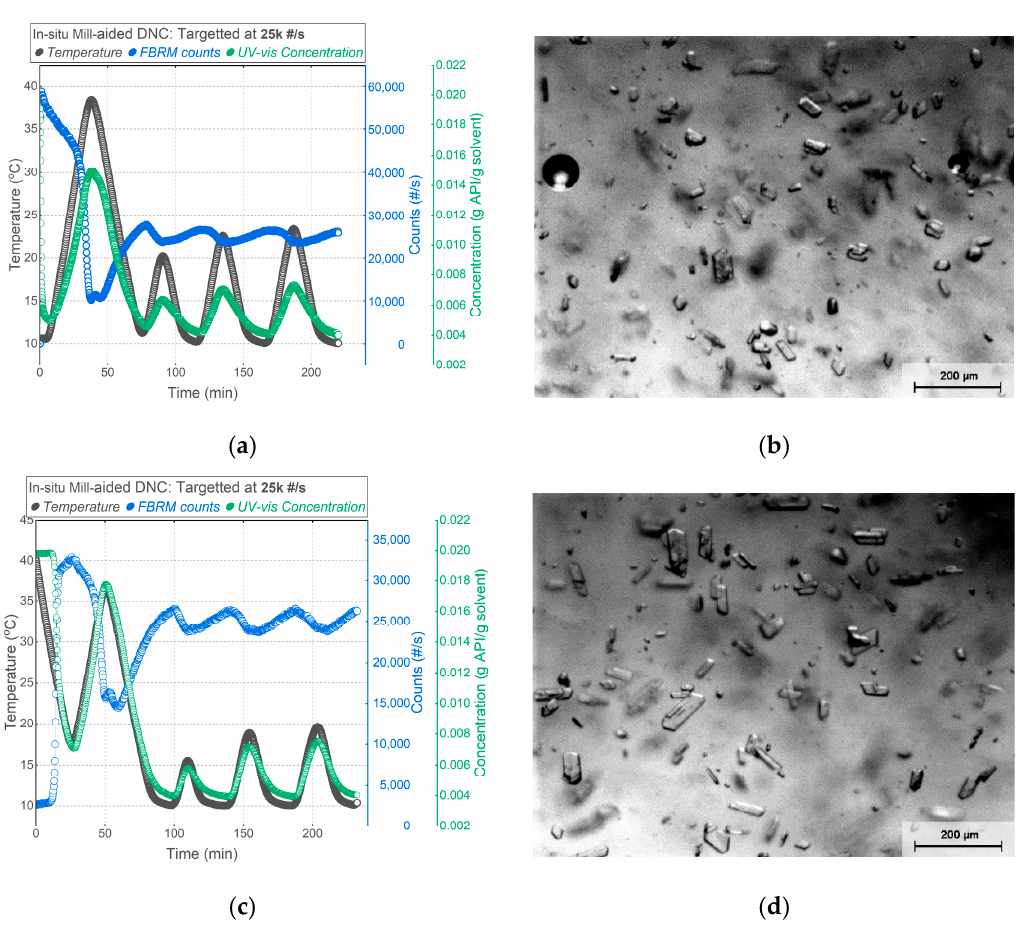
Figure 4. ( a ) Temperature ― , FBRM counts ― , and concentration ― profiles for experiment IMDNC-1, and ( b ) PVM image of final product crystals of IMDNC-1. ( c ) Temperature ― , FBRM counts ― , and concentration ― profiles for experiment IMDNC-2, and ( d ) PVM image of final product crystals for IMDNC-2.